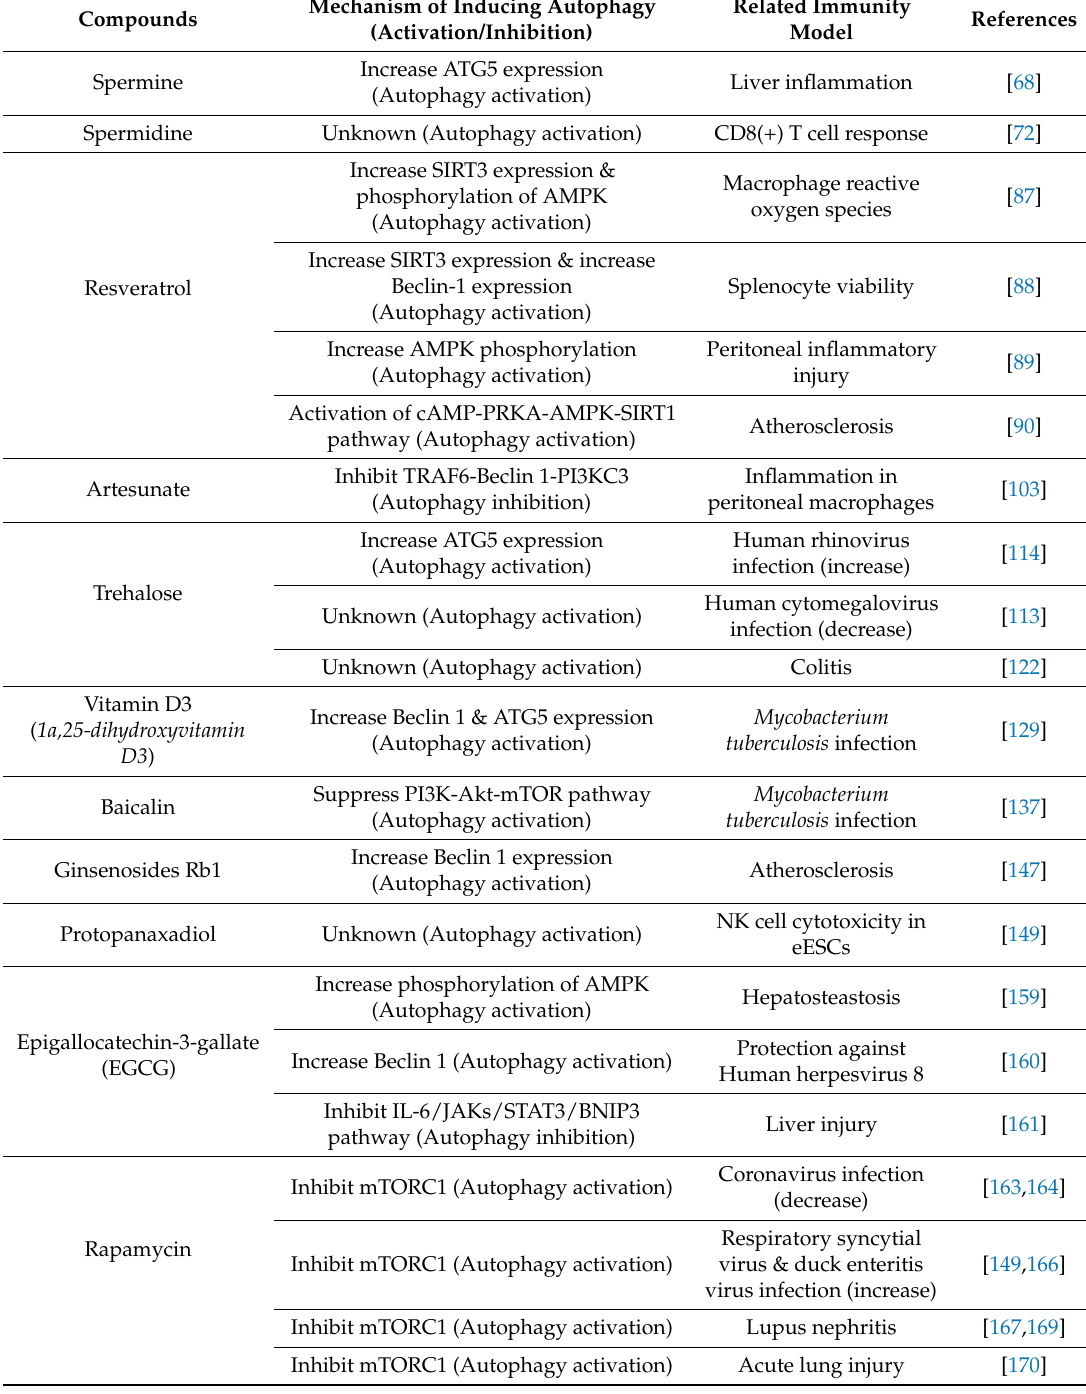
Table 1. Immunity control and molecular mechanism of autophagy modulating